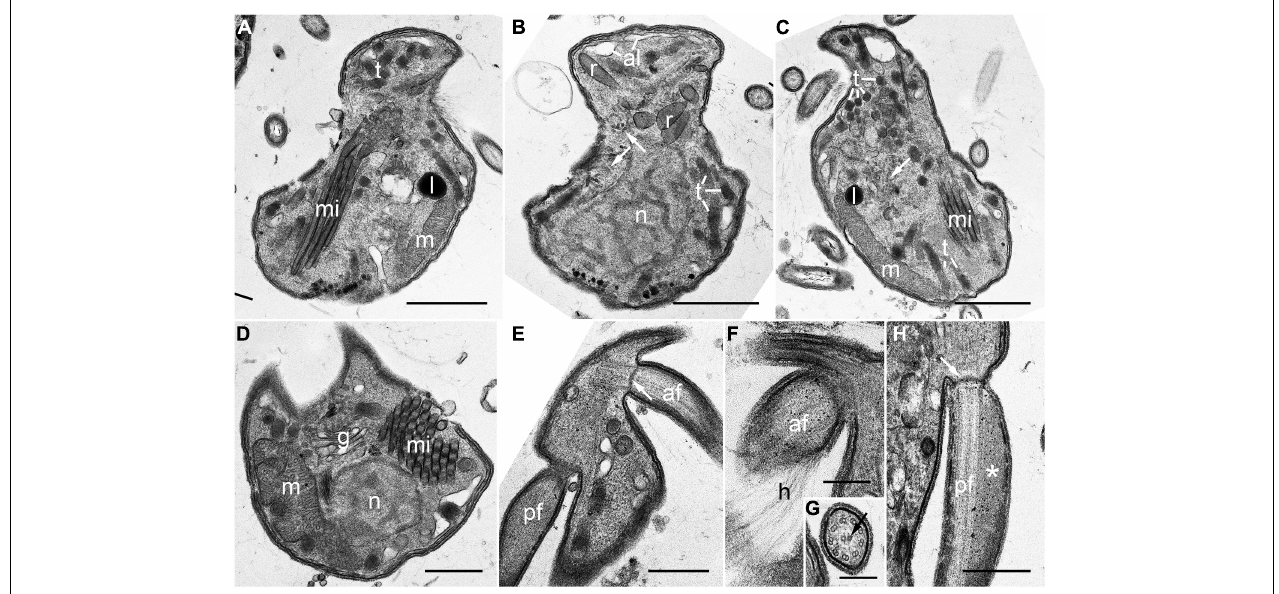
FIGURE 5 | Transmission electron microscopy (TEM) images of the zoospore of Pararosarium dinoexitiosum . (A) Longitudinal section of a zoospore showing bipartite trichocysts (t), micronemes (mi), lipid globule (l), and a mitochondrion (m) with tubular cristae. (B) Longitudinal section of a zoospore showing alveoli (al), rhoptries (r), bipartite trichocysts (t), conoid-associated micronemes (arrows), and the nucleus (n) with condensed chromatin in a reticulated pattern. (C) Longitudinal section of a zoospore showing bipartite trichocysts (t), conoid-associated micronemes (arrow), micronemes (mi), the mitochondrion (m), and a lipid globule (l). (D) Transverse section of a zoospore showing a nucleus (n), micronemes (mi), the Golgi apparatus (g), and the mitochondrion (m). (E) Section showing the anterior flagellum (af) with transverse septum in the transition zone (arrow) and the posterior flagellum (pf). (F) Section showing the anterior flagellum (af) with hairs (h). (G) Detail of the axoneme of anterior flagellum showing a heteromorphic pair of central microtubules (arrow). (H) Longitudinal section of the posterior flagellum (pf) showing the proximal paraxial swelling (asterisk) and transverse septum in the transition zone (arrow). Scale bars: (A–C) = 1 µ m, (D–F,H) = 0.5 µ m, (G) = 0.25 µ m.